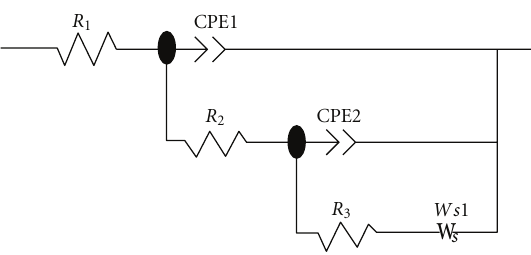
Figure 9: Electrical equivalent circuit proposed to simulate the impedance behaviour of Cu-CS couple in RO water.